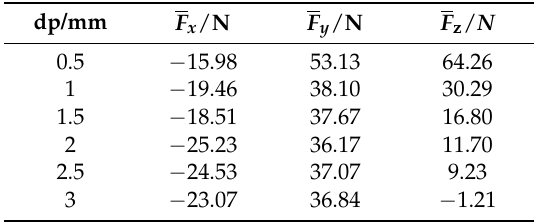
Table 2. Average cutting forces of ball-end milling at different axial